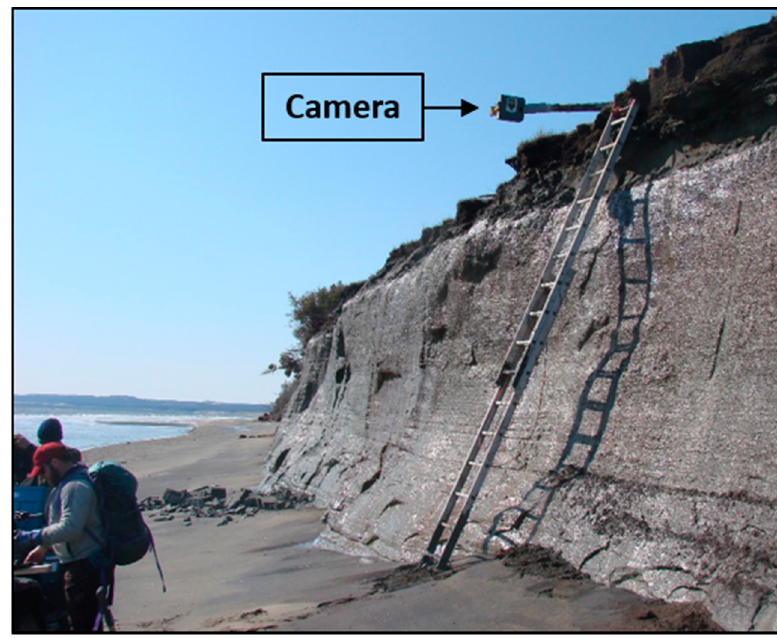
Figure 4. Camera fixed on a horizontal pole (Zone C). Table 3. Environmental variables observed on cameras.